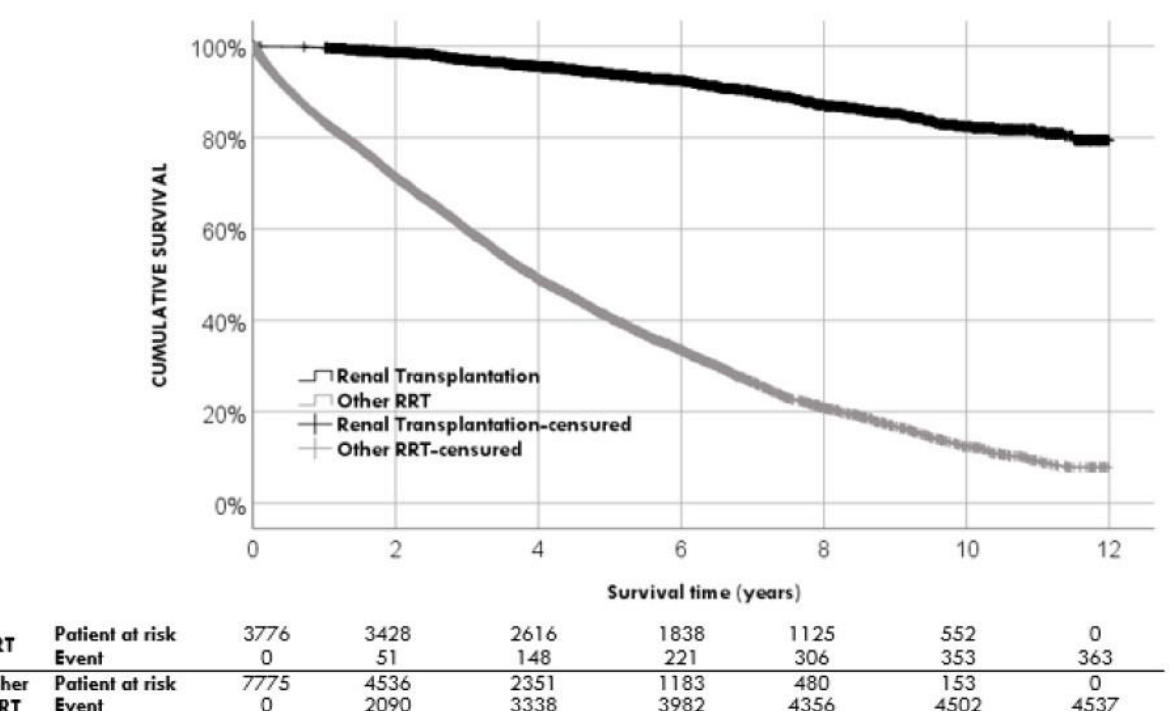
Figure 3. Cox multivariate analysis comparing patients with renal